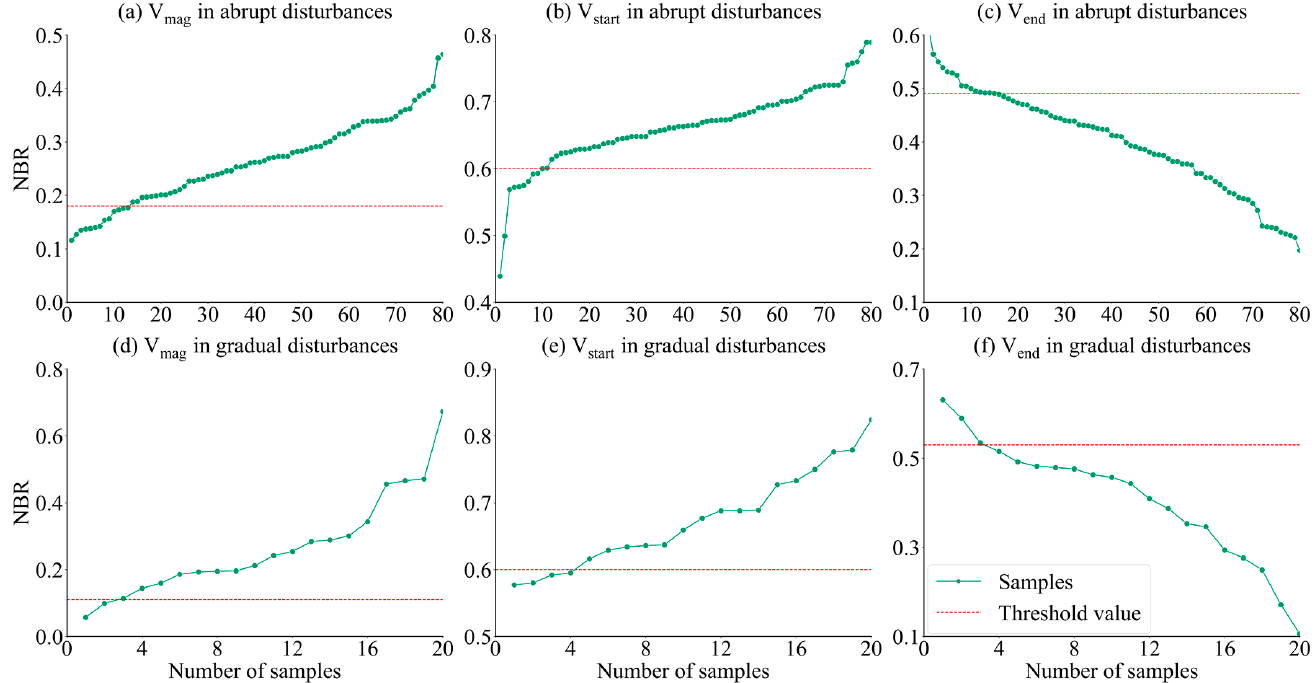
Figure 5. Threshold values for detecting abrupt and gradual disturbances: ( a – c ) V mag , V start , and V end for abrupt disturbances, and ( d – f ) V mag , V start , and V end for gradual disturbances. Th red dotted lines are the values of the corresponding mean ± standard deviation.